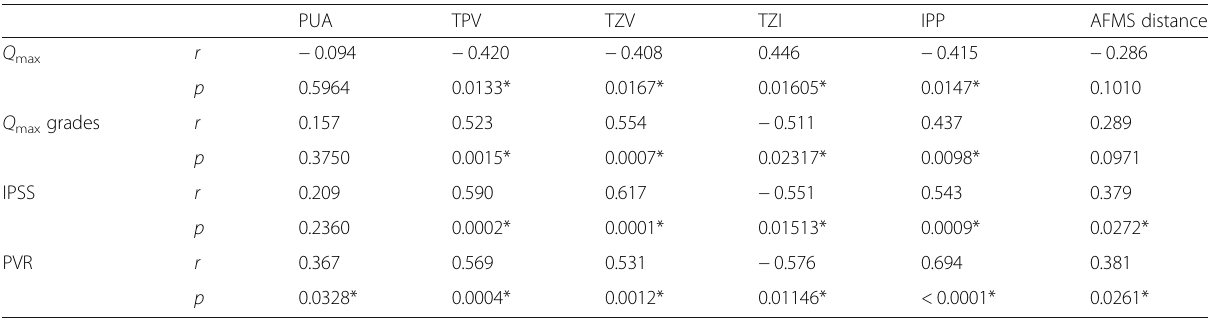
Table 2 Pearson correlation coefficients ( r ) between Q max , Q max grades, IPSS, PVR and PUA, TPV, TZV, TZI, IPP, AFMS distance PUA TPV